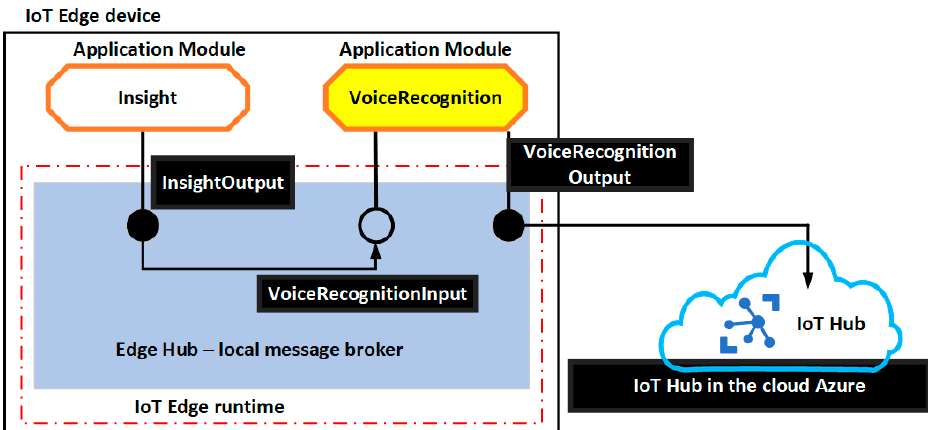
Figure 6. Routes in IoT Edge Hub deployed on the device.